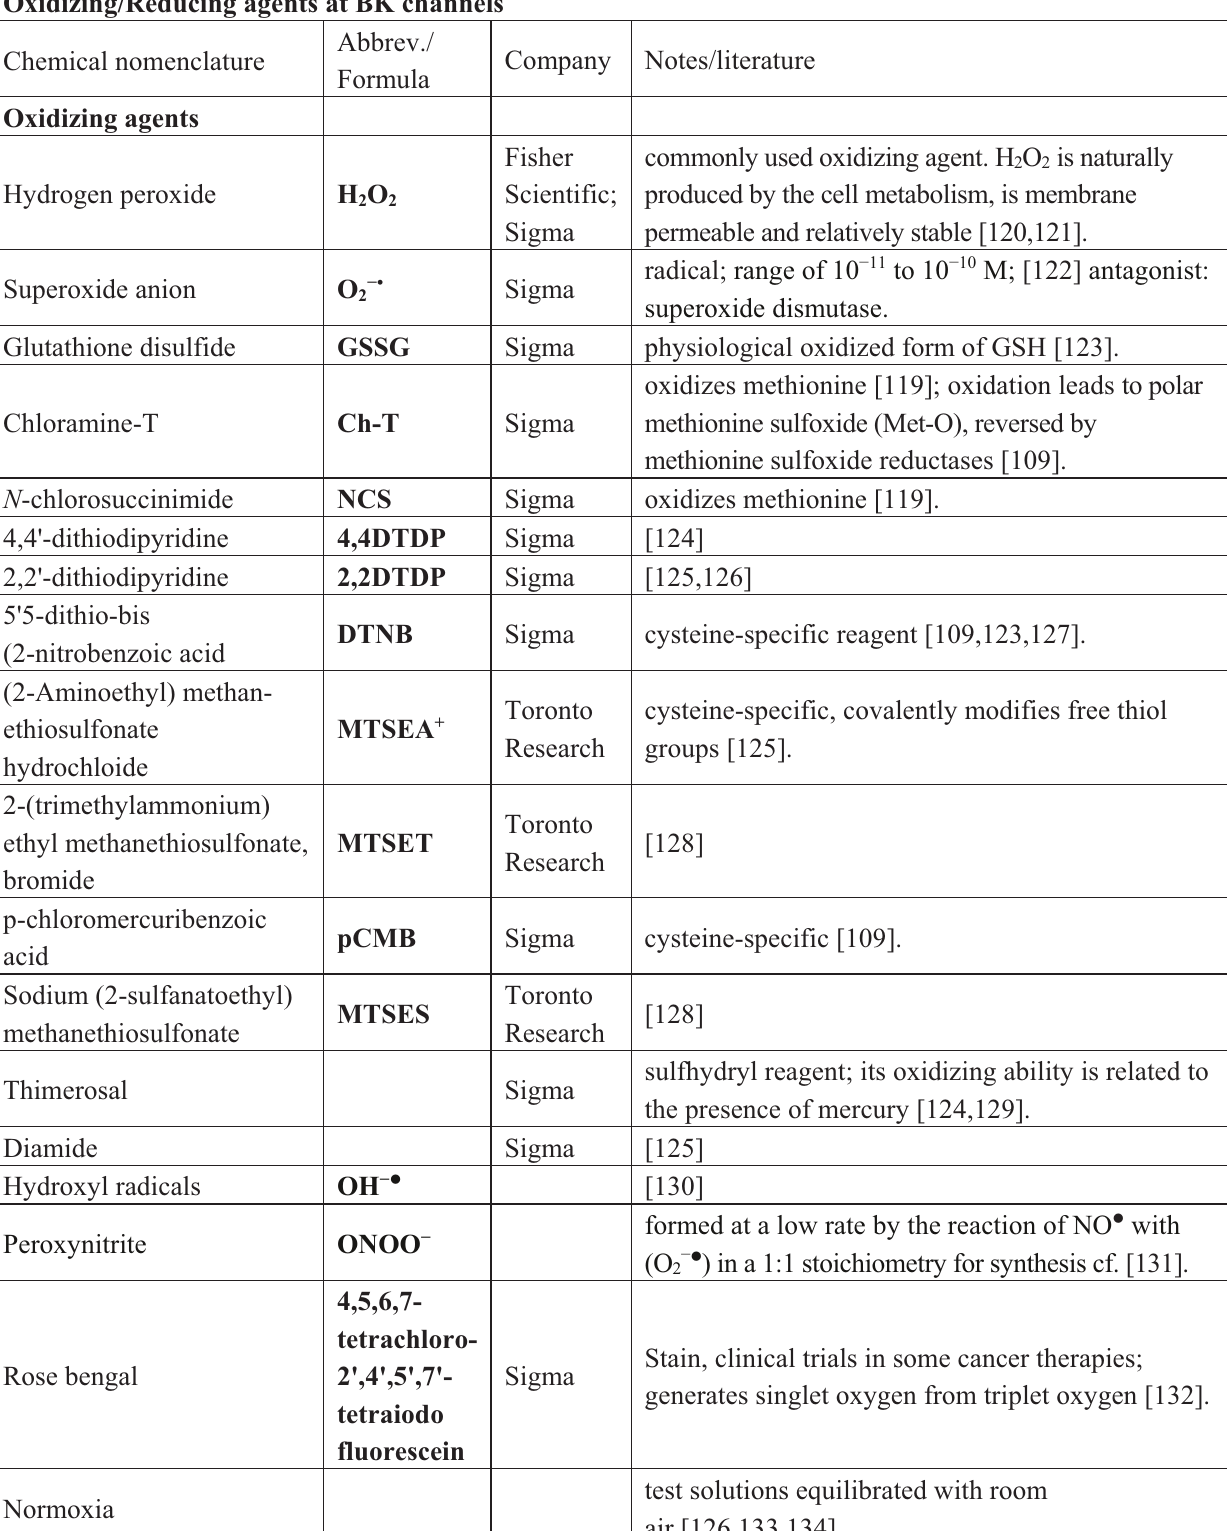
Table 1. Reactive oxygen species (ROS) agents, reducing agents and gasotransmitters that are produced by cells and/or are experimentally used chemicals for modulating BK